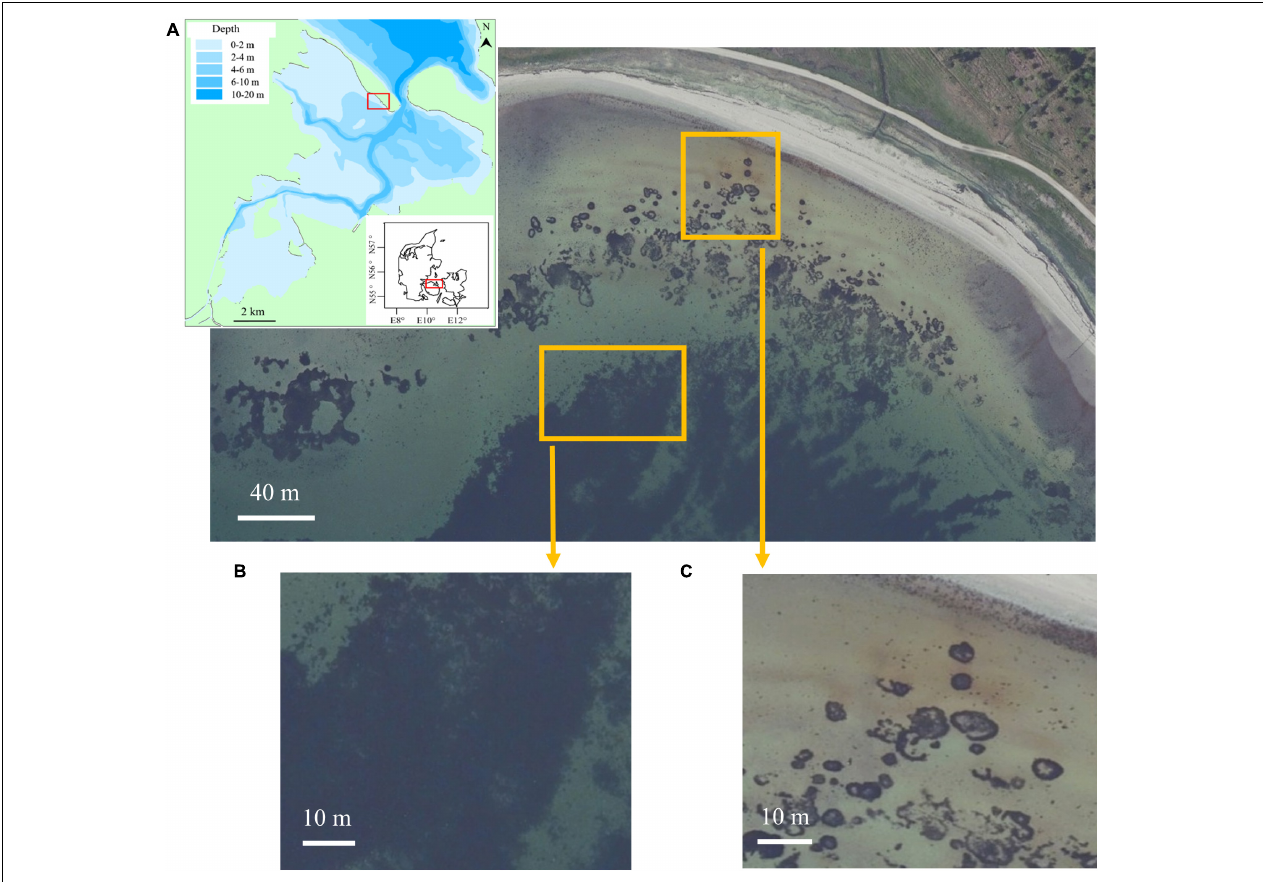
FIGURE 1 | Panel (A) shows the location of the study beach and potential nearshore marine macrophyte subsidies for beach wrack (Denmark’s Area Information, Danmarks Miljøportal). The map in the left corner in panel (A) shows the bathymetry of Odense Fjord, where the study beach is located. Panel (B) is the subsidy area of macroalgae Fucus vesiculosus and Fucus serratus , identified by snorkeling. Panel (C) is the subsidy area of eelgrass, Zostera marina , identified by